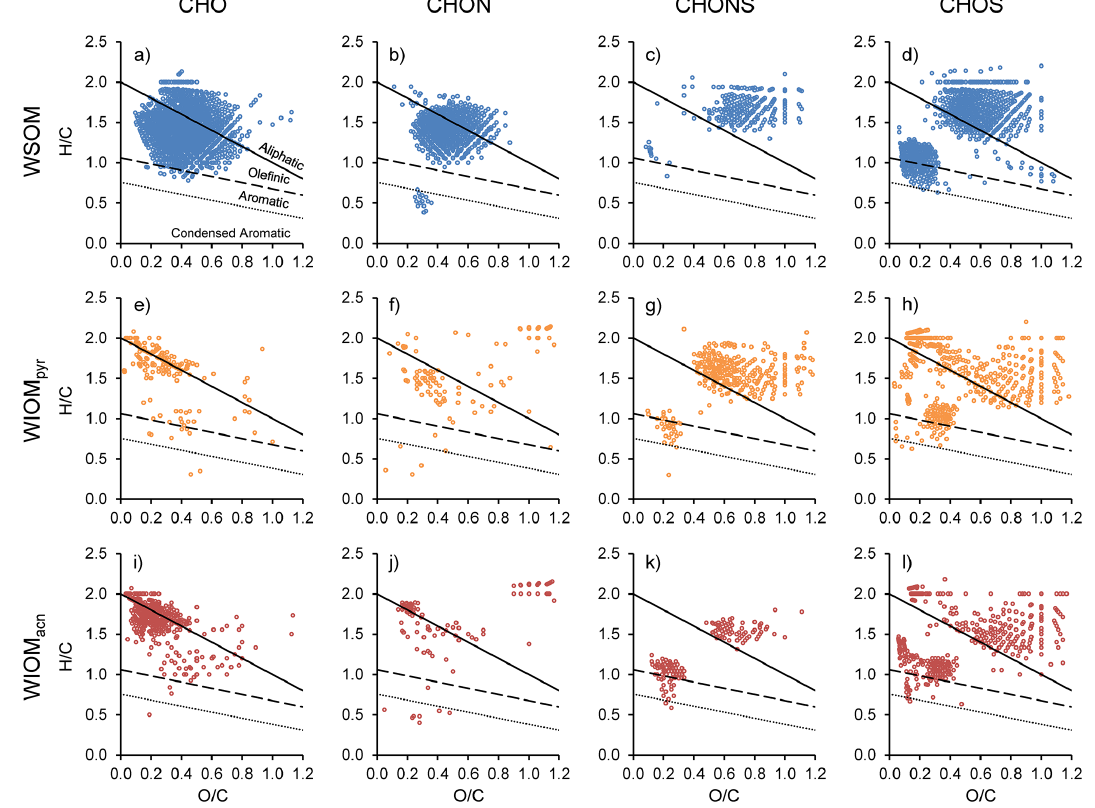
Figure 4. Van Krevelen diagrams for molecular formulas assigned to the (a–d) WSOM, (e–h) WIOM pyr , and (i–l) WIOM acn extracts. Any formula present in WSOM has been removed from the WIOM pyr and WIOM acn plots. Each diagram is plotted based on elemental content of each molecular formula (CHO, CHON, CHONS, and CHOS). The labeled regions in (a) WSOM CHO formulas correspond to their aromaticity based on AI mod and these regions are consistent for all of the diagrams. Formulas above the solid line are aliphatic, just below the solid line are olefinic, below the dashed line are aromatic, and below the dotted line are condensed